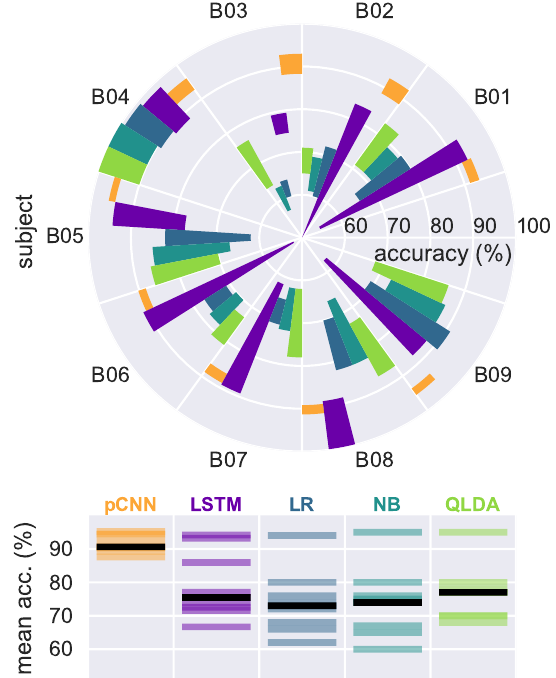
Figure 6. MI classification accuracies from nine subjects using five different classifiers. The polar bar plot shows the accuracy range (mean ± standard deviation) achieved by the five models for each of the nine subjects. The lower panel subsumes for each algorithm the nine mean accuracies achieved, black bars indicate the median